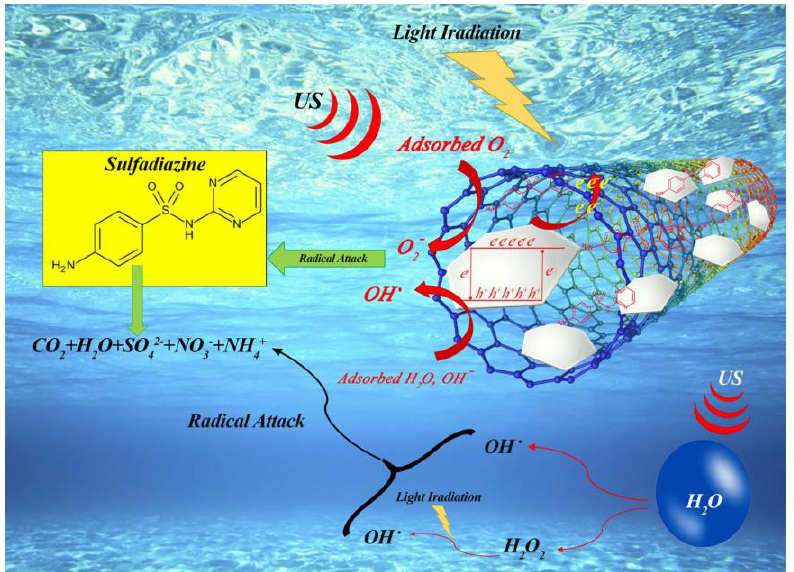
Figure 14. The possible mechanism for the detoxification of SDZ-containing wastewater in the MCs/UV/US system. Reprinted with permission from [48]. MCs/UV/US system. Reprinted with permission from